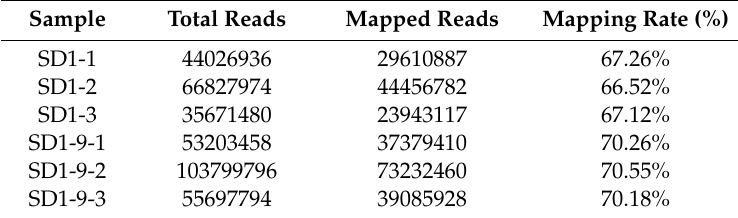
Table 4. Read numbers after alignment with the reference genome.